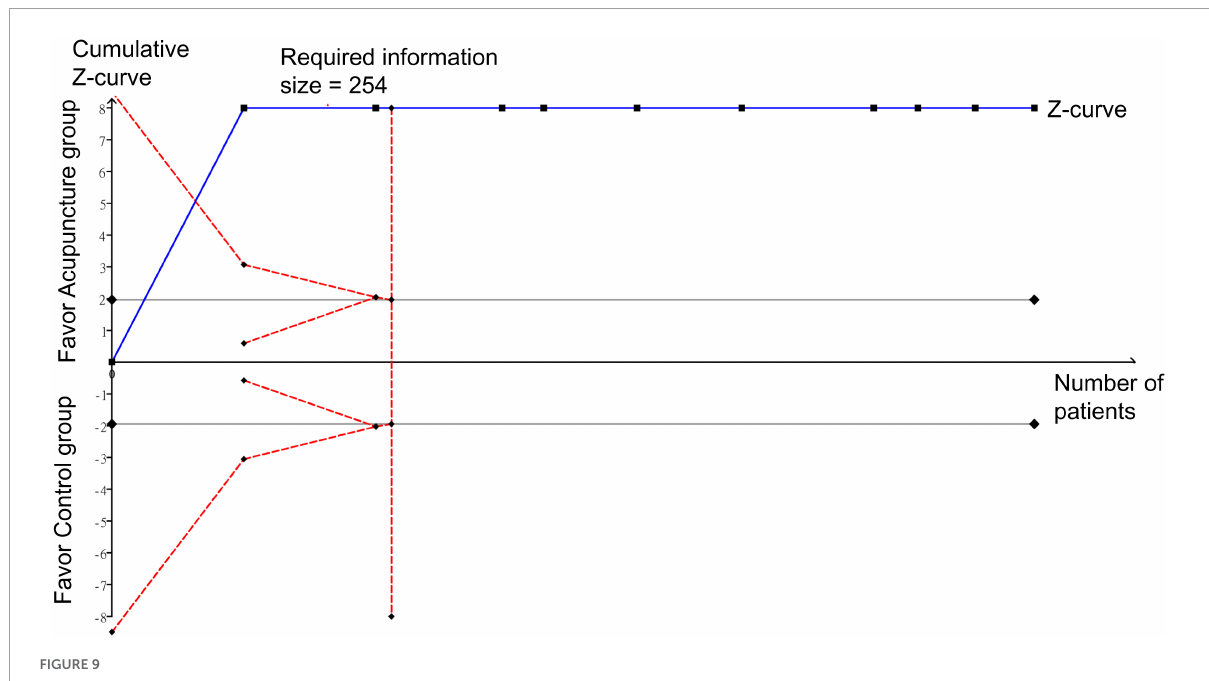
FIGURE9 Trial sequential analysis of the robustness of evidence supporting the difference in time to pain relief between the acupuncture and control groups.